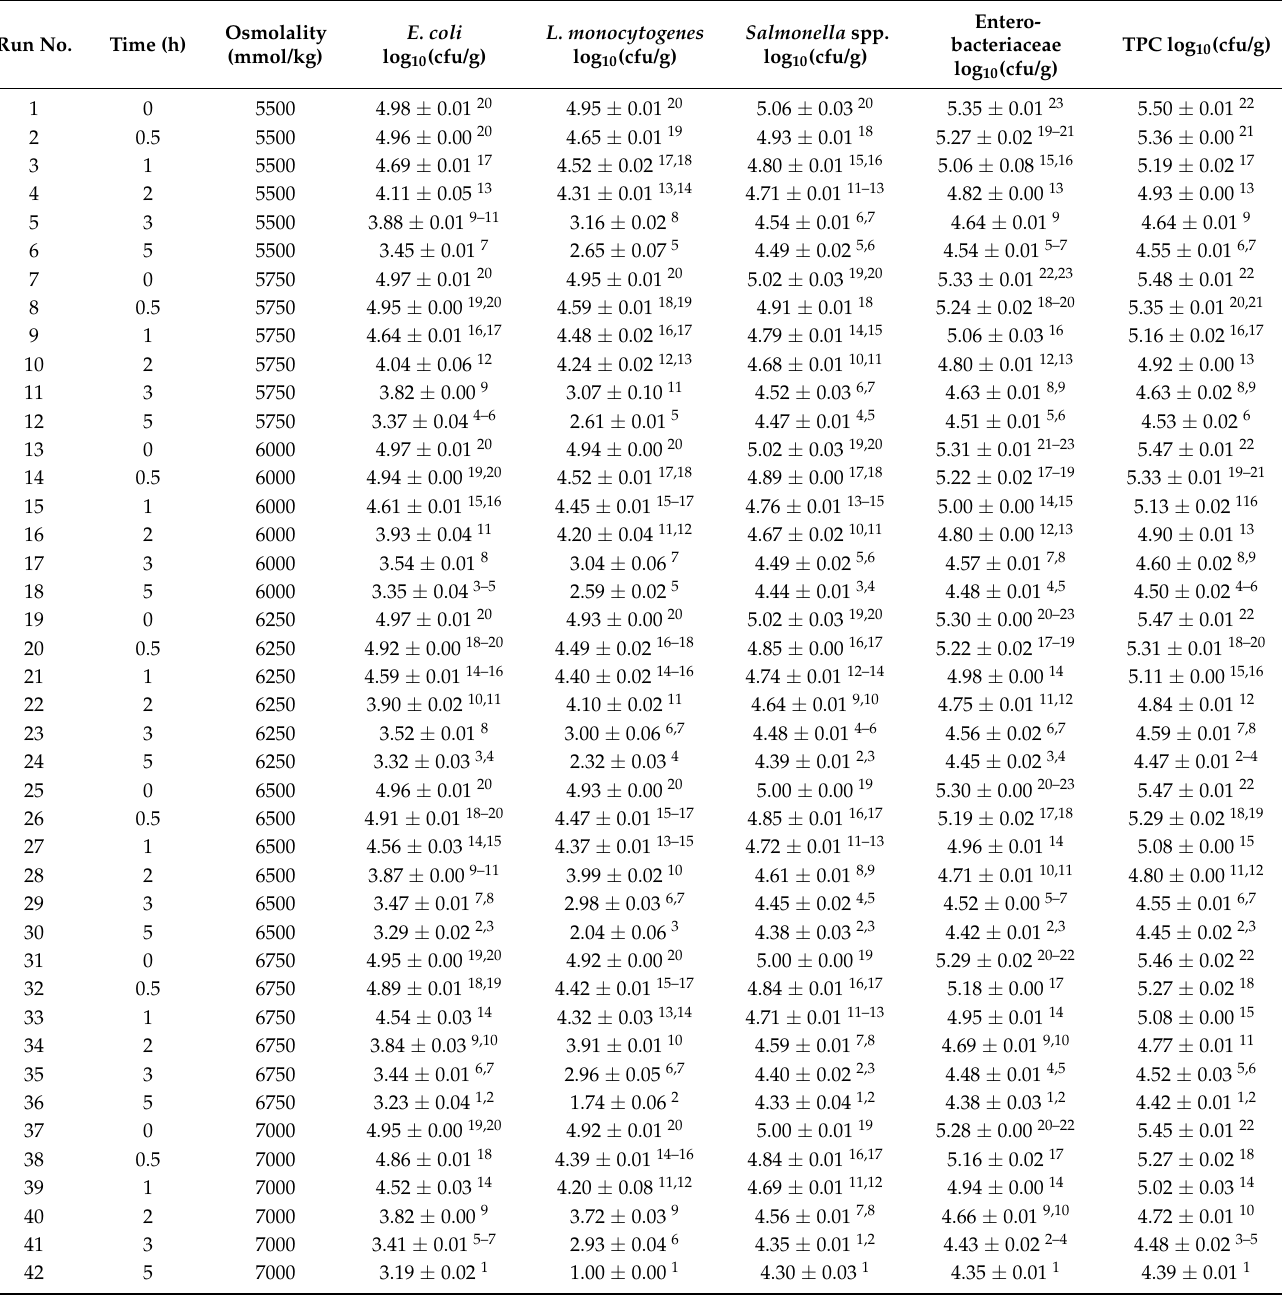
Table 1. Average values and standard deviations of selected microorganisms’ numbers in molasses at different exposure times and of different